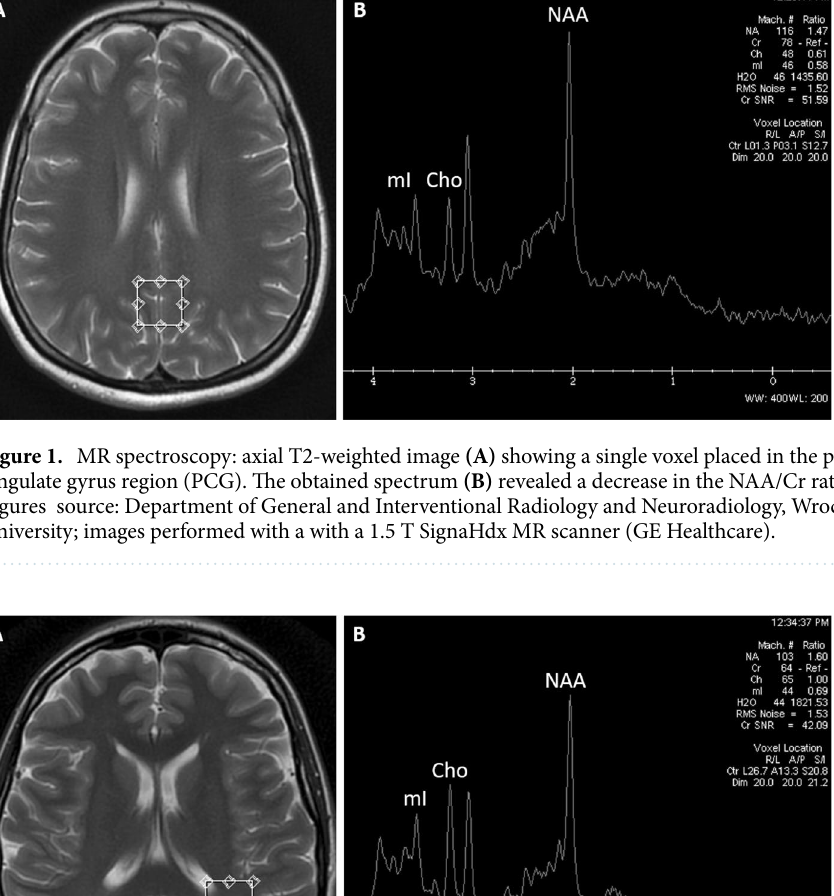
cortex—PCG (Fig. 1) and the left parietal white matter—PWM (Fig. 2). The total acquisition time was 3 min 45 s for each voxel. MR spectroscopy studies were conducted by using the automated single-voxel MR spectroscopy package Proton Brain Examination/Single Voxel (PROBE/SV; GE Medical Systems, Milwaukee, WI). The pre- imaging algorithm of the PROBE software automatically adjusted the transmitter and receiver gains and centre frequency. The local magnetic field homogeneity was optimised with the three-plane auto-shim procedure with linear gradient shimming, and the flip angle of the third water-suppression pulse was adjusted for chemical shift water suppression (CHESS) before PRESS acquisition. Each spectrum was automatically fitted to four peaks corresponding to the levels of N-acetylaspartate (NAA) (2.02 ppm), total creatine (Cr) (3.03 ppm), choline- containing compounds (Cho) (3.23 ppm) and myo-inositol (mI) (3.56 ppm). Metabolite intensity ratios of NAA/ Cr, Cho/Cr, and mI/Cr were automatically calculated at the end of each PROBE/SV acquisition. MRS data were post-processed by means of software provided by the manufacturer (GE workstation, ADW 4.4). The ratios of NAA, Cho, and mI to creatine (NAA/Cr, Cho/Cr, mI/Cr, respectively) were assessed. We used